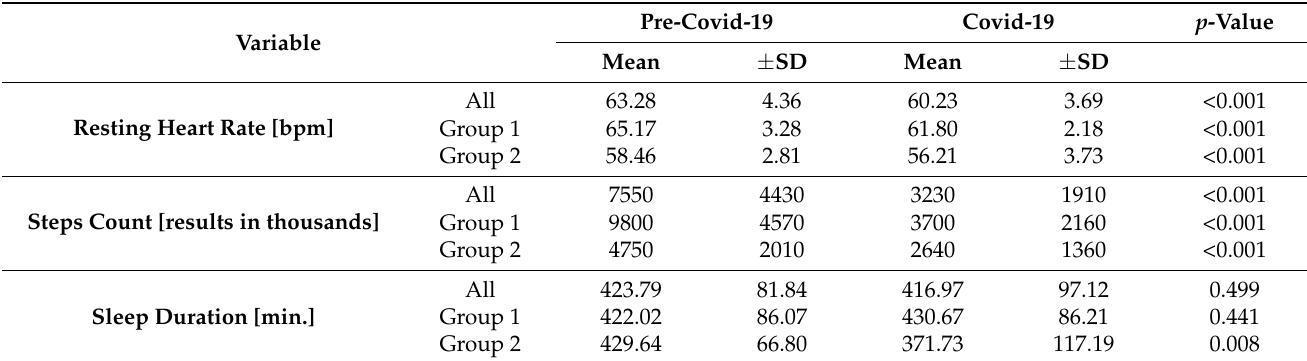
Table legend: All—all participants, Group 1—professionally active participants (younger participants), Group 2—octogenarians (older participants), bpm—beats per minute, min—minutes, SD—standard deviation. Table 3. General characteristics of the study participants.